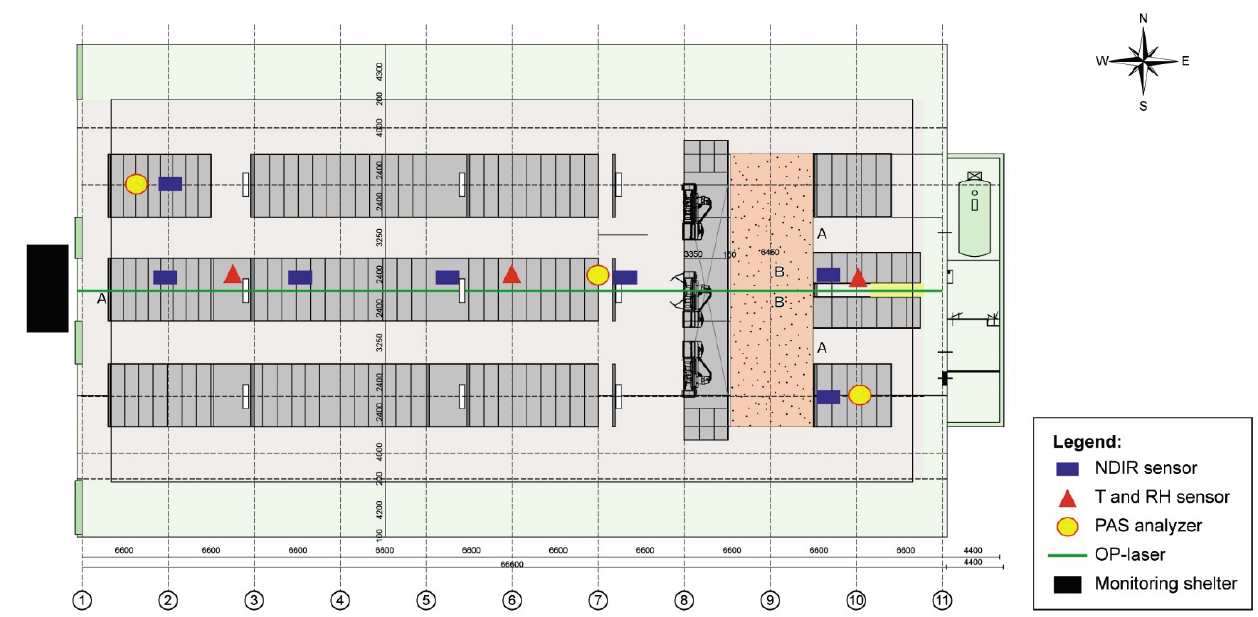
Figure 5. Plan view of the investigated barn with the allocation of the different carbon dioxide (CO 2 ) measuring devices and temperature (T) and relative humidity (RH) sensors (not to scale). The approximate distance between NDIR sensors in the central axis is 13